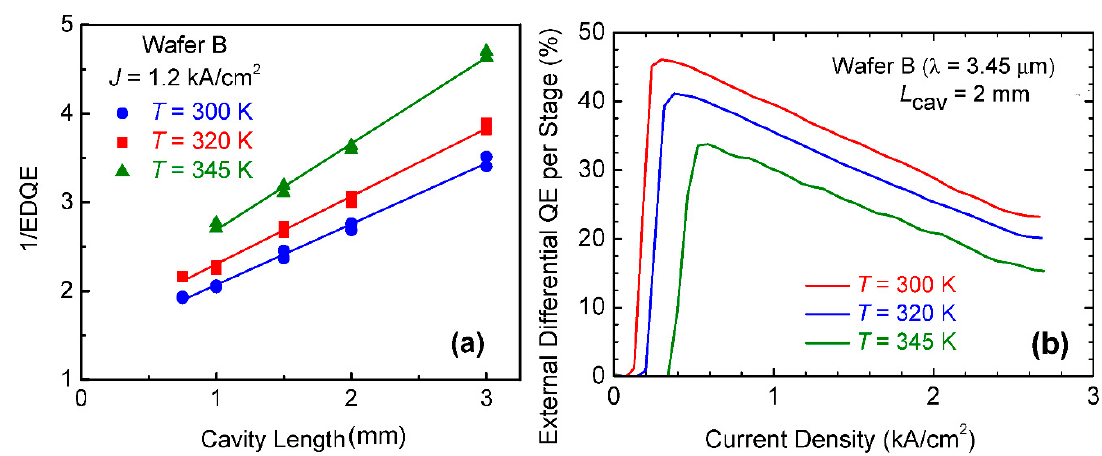
Figure 25. ( a ) Inverse external differential quantum efficiency per stage as a function of cavity length for a broad-area 7-stage ICL from Wafer B ( λ ≈ 3.45 μ m) operating at three different temperatures (300, 320, and 345 K). ( b ) EDQE per stage for one of the same ICLs ( L cav = 2 mm) as a function of injection current density at the same three operating temperatures. The efficiency above the threshold is seen to “droop” substantially. From Ref. [87].